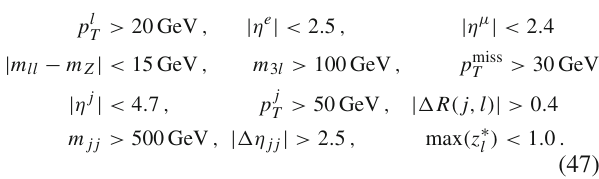
Fig. 9 W Z invariantmass(upperrow)andtransversemass(lowerrow) distributions for VBS production of W Zjj events at the LHC. Three panels show expected event numbers per bin for a run 2 integrated lumi- nosity of 137fb − 1 while the upper right panel is normalized to the SM.